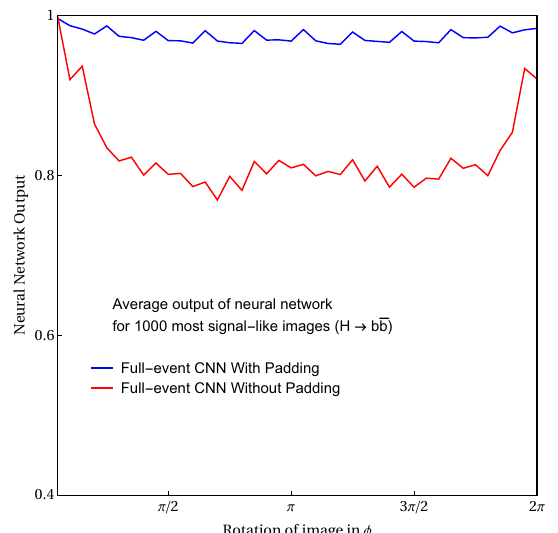
Figure 10 . The average signal neural network output after rotating the images by a (cid:12)xed